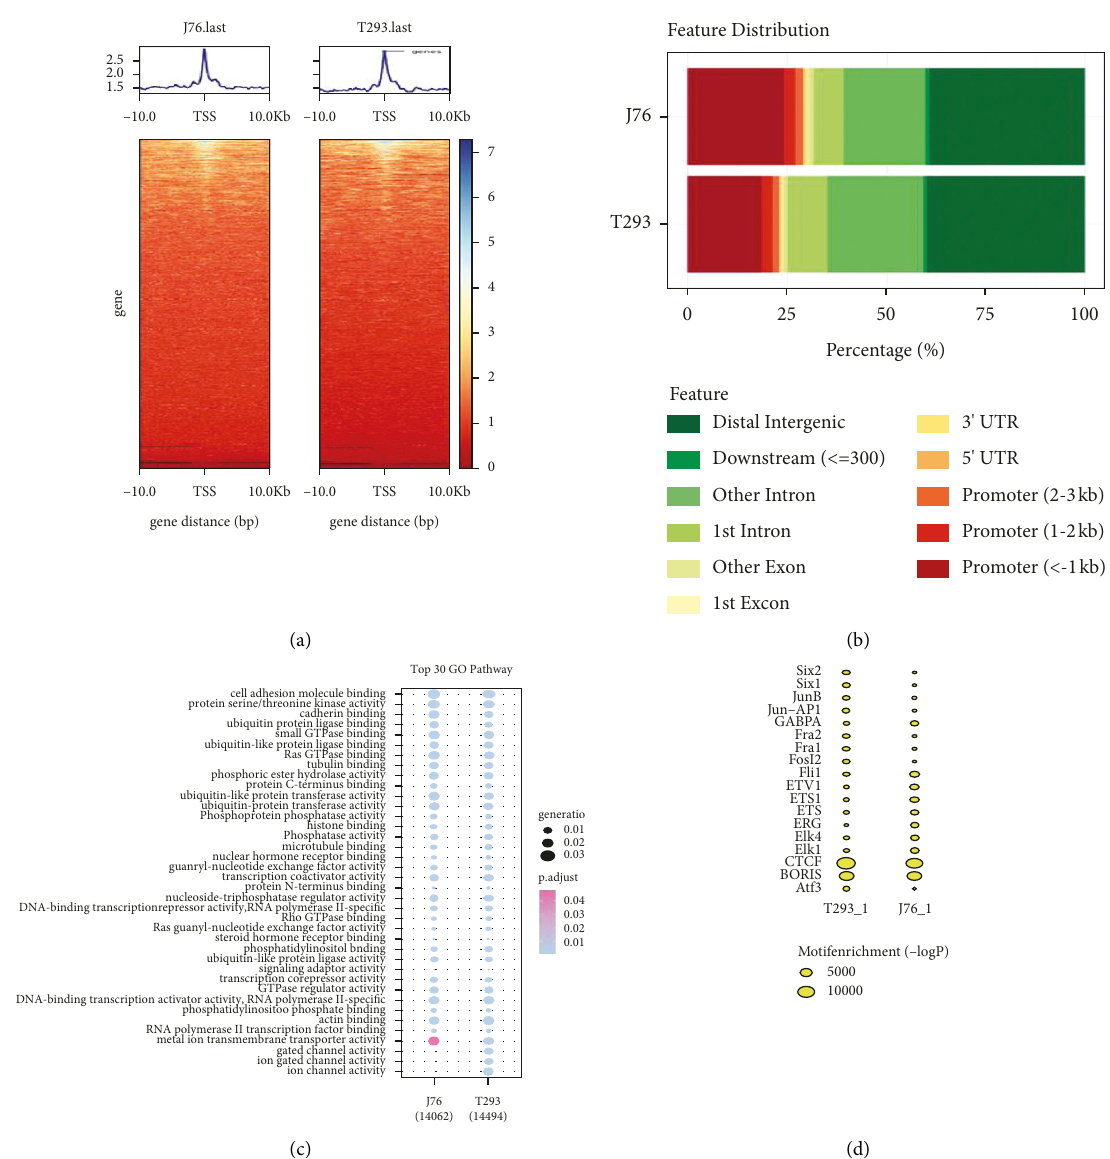
Figure 3: Main procedures and analysis process of ATAC seq in J76 cells and 293Tcells. (a) Heatmap analysis of the enrichment of ATAC- seq signal around TSS. (b) Distribution of chromatin open region peaks in gene functional elements. (c) Go enrichment analysis of peak- related genes in the chromatin open region of J76 cells and 293T cells. (d) Comparison of motif analysis results between J76 cells and 293T